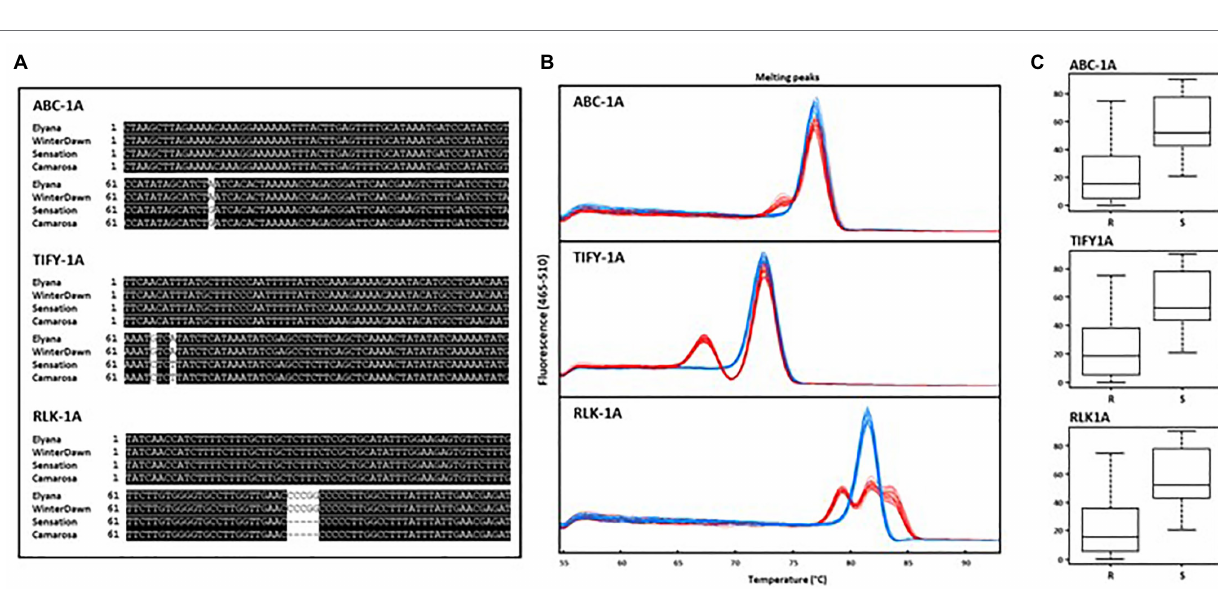
FIGURE 7 | Development of gene-specific HRM markers and validation with association mapping breeding panels. (A) Multiple sequence alignment view of polymorphism flanking region of ABC-1A, TIFY-1A, and RLK-1A. (B) High resolution melting curve patterns for ABC-1A, TIFY-1A, and RLK-1A testing with 169 accessions. The blue line shows the susceptible pattern and red line depicts the resistant pattern. (C) Boxplot analysis of area under disease progression curve (AUDPC) for genotyping of three markers ABC-1A, TIFY-1A, and